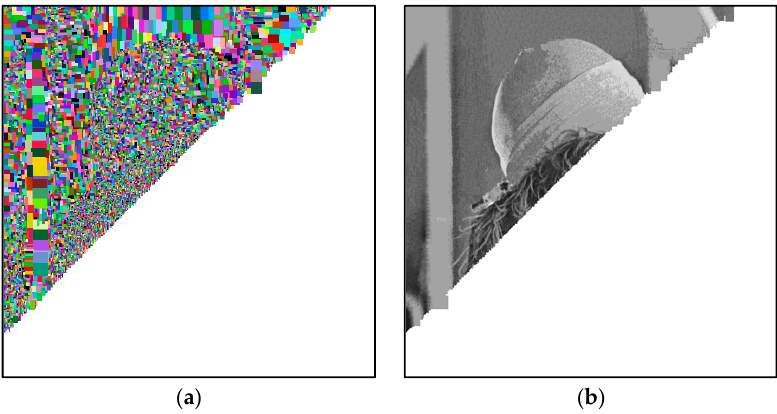
Figure 6. Graphical representation of: ( a ) the progress (in false-colors ) of the compression stage; ( b ) the progress of the decompression stage.